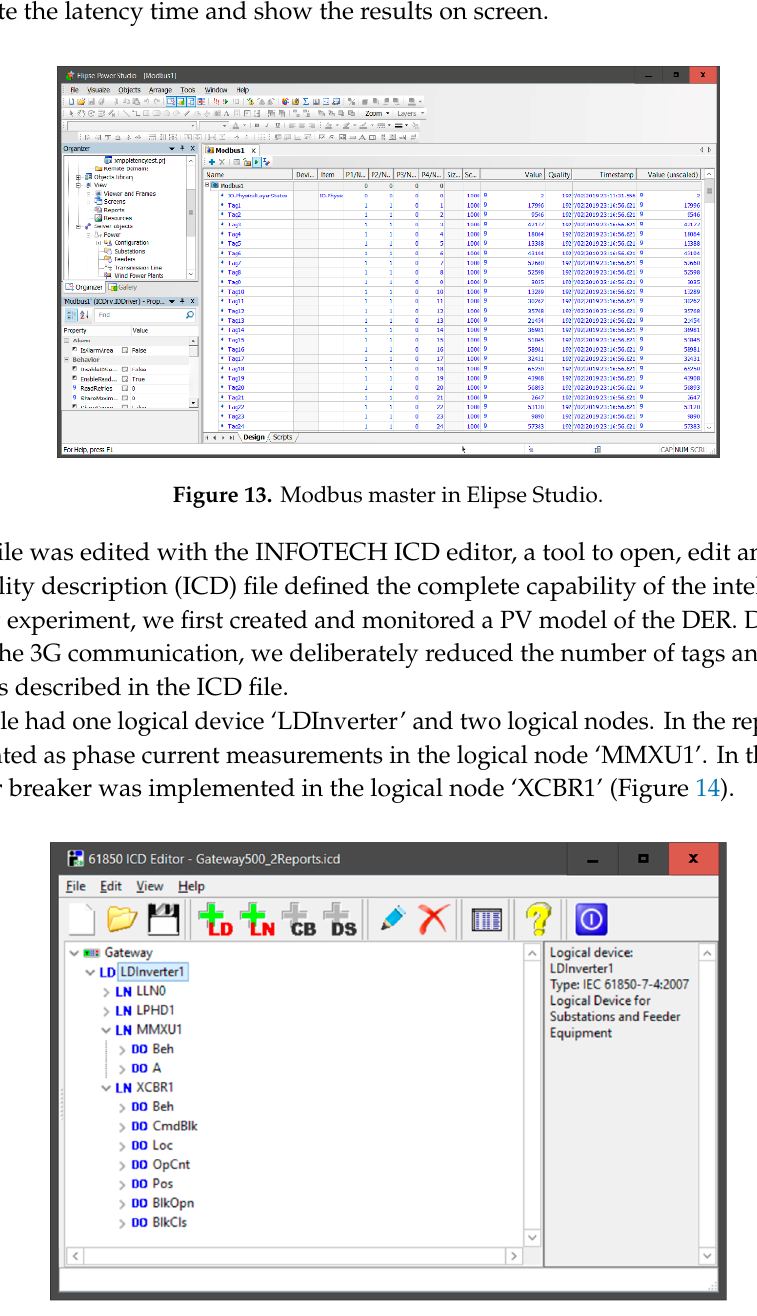
Figure 12. Modbus slave in Modbus simulator.